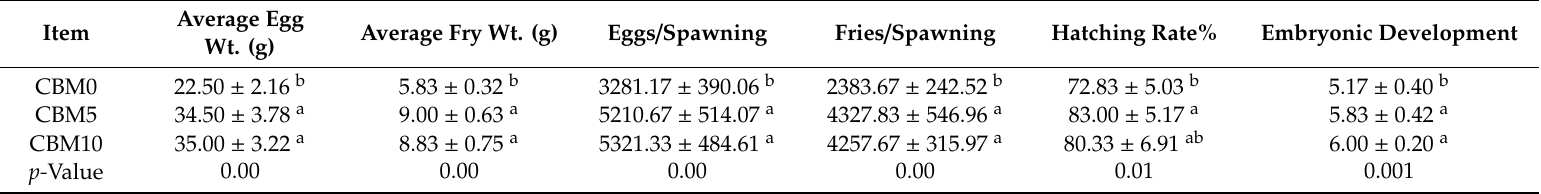
Table 7. E ff ect of dietary supplementation of cacao bean meal (CBM) on the reproductive performance of female broodstock C. auratus